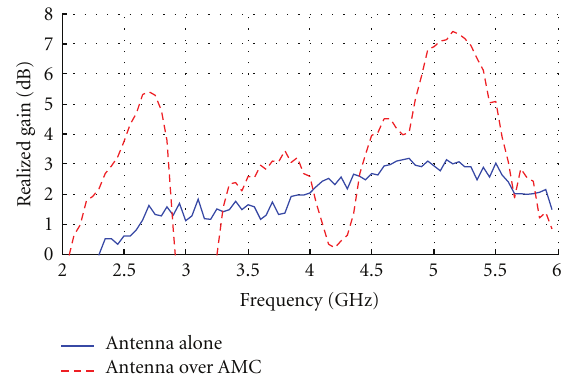
Figure 20: Measured realized gain for the CPW-fed monopole antenna alone and for the CPW-fed monopole antenna over